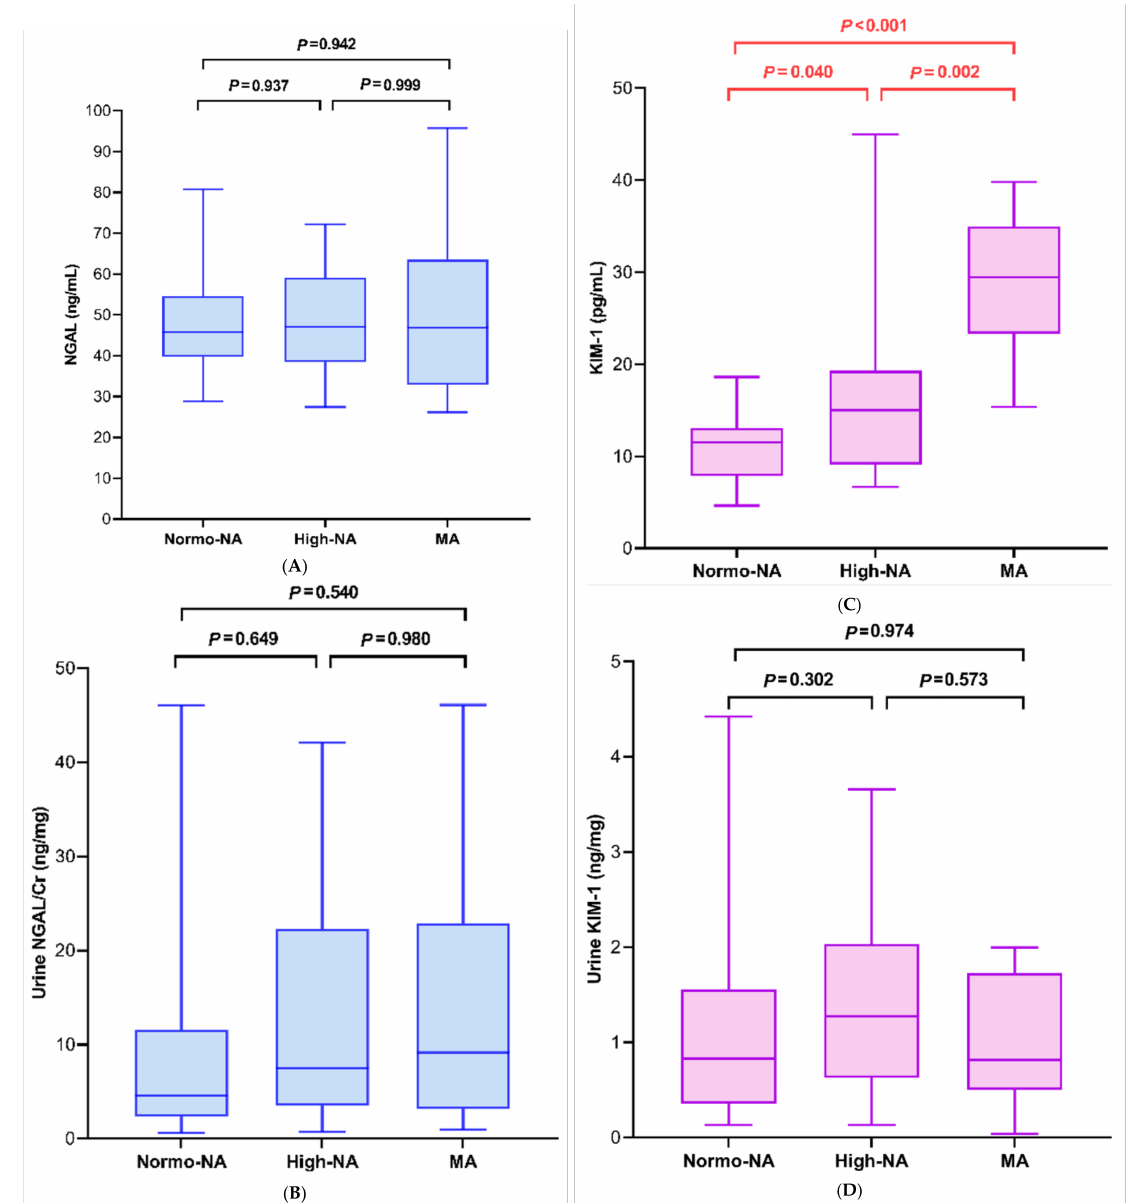
Figure 1. Diabetic children were subcategorized into three groups with regard to the albumin creatinine ratio and box plots were drawn to compare: ( A ) serum neutrophil gelatinase-associated lipocalin (NGAL), ( B ) urine NGAL/g creatinine, ( C ) serum kidney injury molecule-1 (KIM-1) and ( D ) urine KIM-1/g creatinine. The boxes represent the interquartile range. The lines inside the boxes represent the median value. The whisker represents the lowest and highest observations,